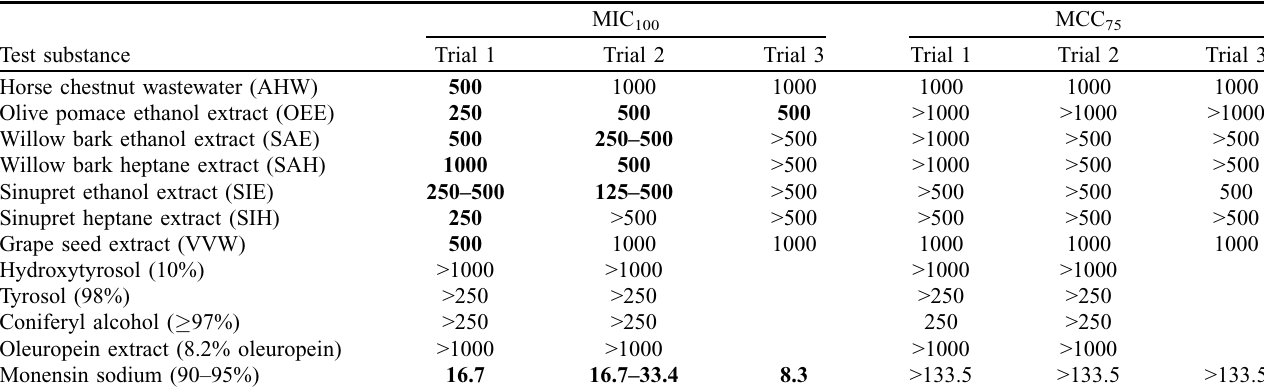
Table 2. In vitro anti-cryptosporidial activity of plant by-products . Results from in vitro testing of 42 samples derived from 18 different plant by-products, four samples related to olives and monensin sodium salt against C. parvum . MIC 100 indicates the minimal concentration of a sample, at which complete parasite inhibition was observed ( l g mL (cid:2) 1 for solid samples, nL mL (cid:2) 1 for the oleuropein extract or nM for monensin). Samples that were active in the first trial were tested in three independent trials in total, whereas the others were not tested again. Four samples related to olives were tested in two trials, monensin in three. MCC 75 is the minimal cytotoxic concentration against HCT-8 host cells (<75% host cell viability). Inhibitory concentrations within the non-toxic range for host cells are marked by bold print. The complete results table can be found as an online resource (Table S1).